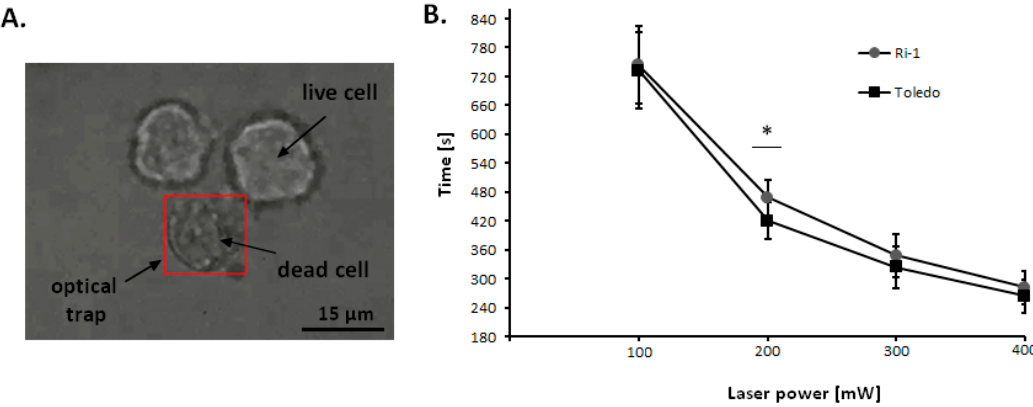
Figure 3. Trypan blue accumulation on the surface of untreated living Ri-1 cells, while dead cell was held in optical trap >300 s at 300 mV of laser power. The red frame indicates the area of operating range of the optical trap, while the focused laser beam is located in the center of trapped specimen ( A ). Characterization of cell death under varied laser power using Trypan blue for Ri-1 and Toledo cell lines in optical tweezers. The measurements were repeated for 10 individual cells for each laser power. The symbol (*) indicates a significant difference in cell death between Ri-1 and Toledo cells considering a p -value < 0.05; Student’s t -test ( B ).